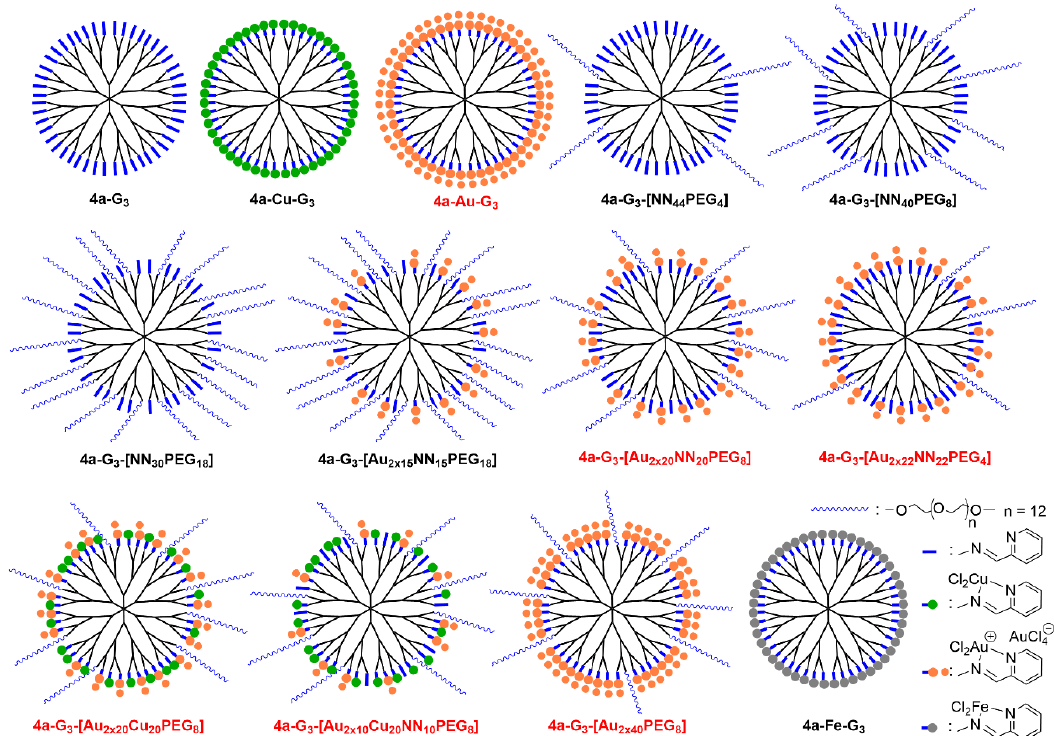
Figure 7. Schematization of the functionalization of the third generation dendrimer. For dendrimers obtained by the stochastic functionalization of the surface, only one of the innumerable possible structure is shown. The names in red correspond to the most active dendrimers.